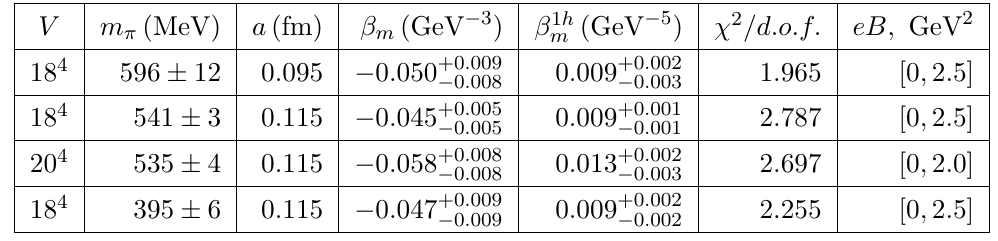
of the charged m